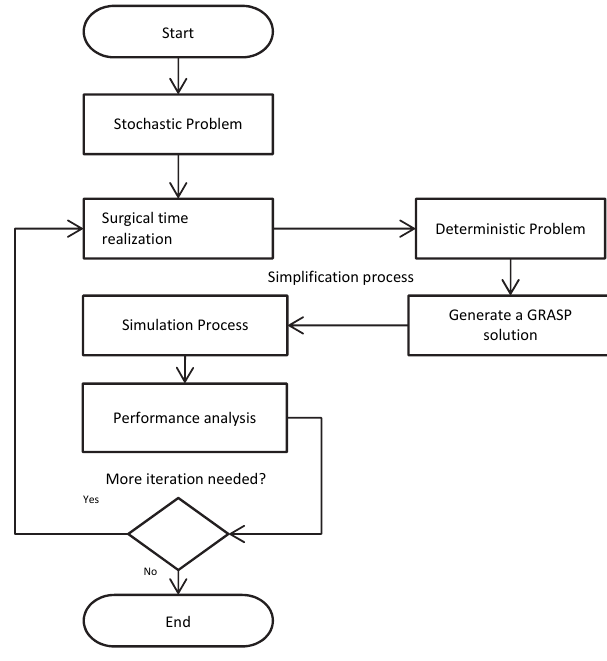
Fig. 1. Simulation-Optimization approach (Adapted from (Juan et al.,